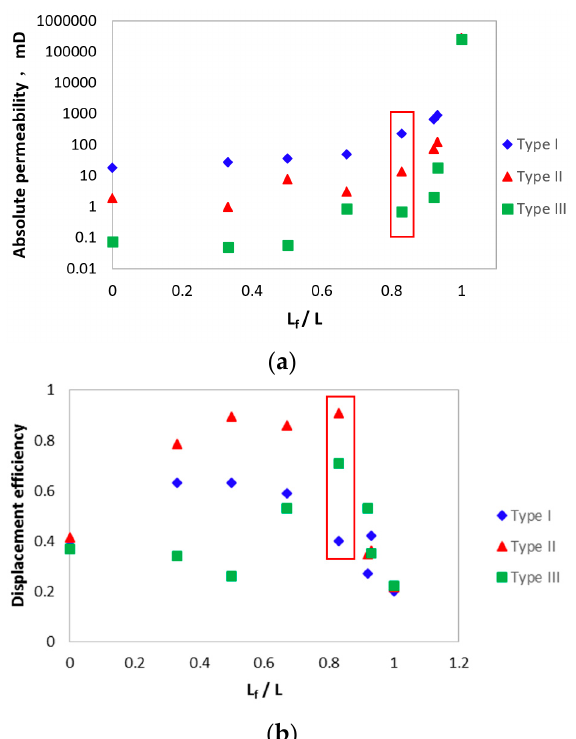
Figure 5. The influence of fracture length on absolute permeability and displacement efficiency. ( a ) The influence of fracture length on absolute permeability; ( b ) The influence of fracture length on displacement efficiency.